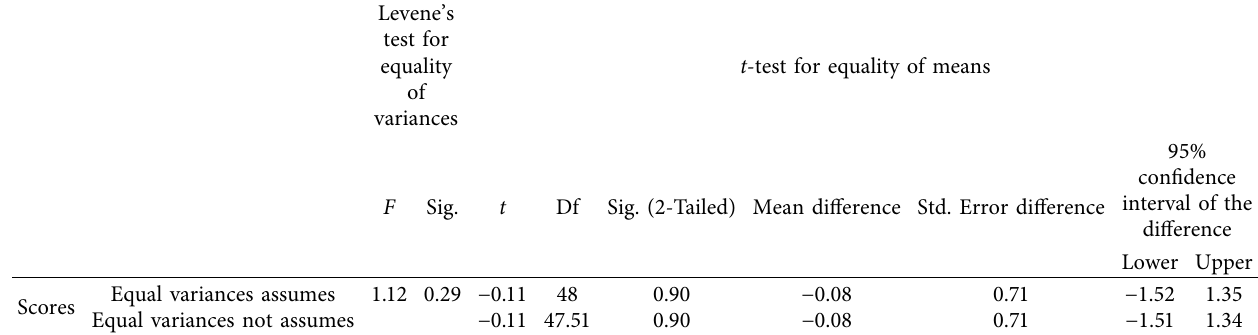
Table 2: Independent Samples t -test (Pretest of Both Groups).